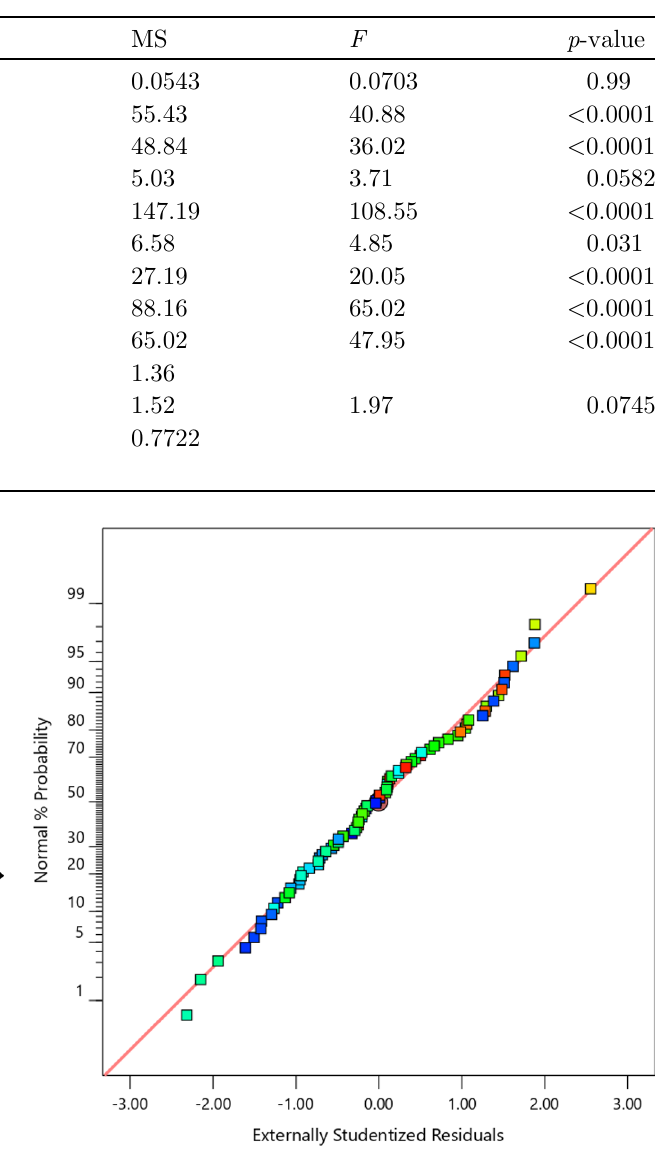
Table 8. ANOVA of top surface roughness.